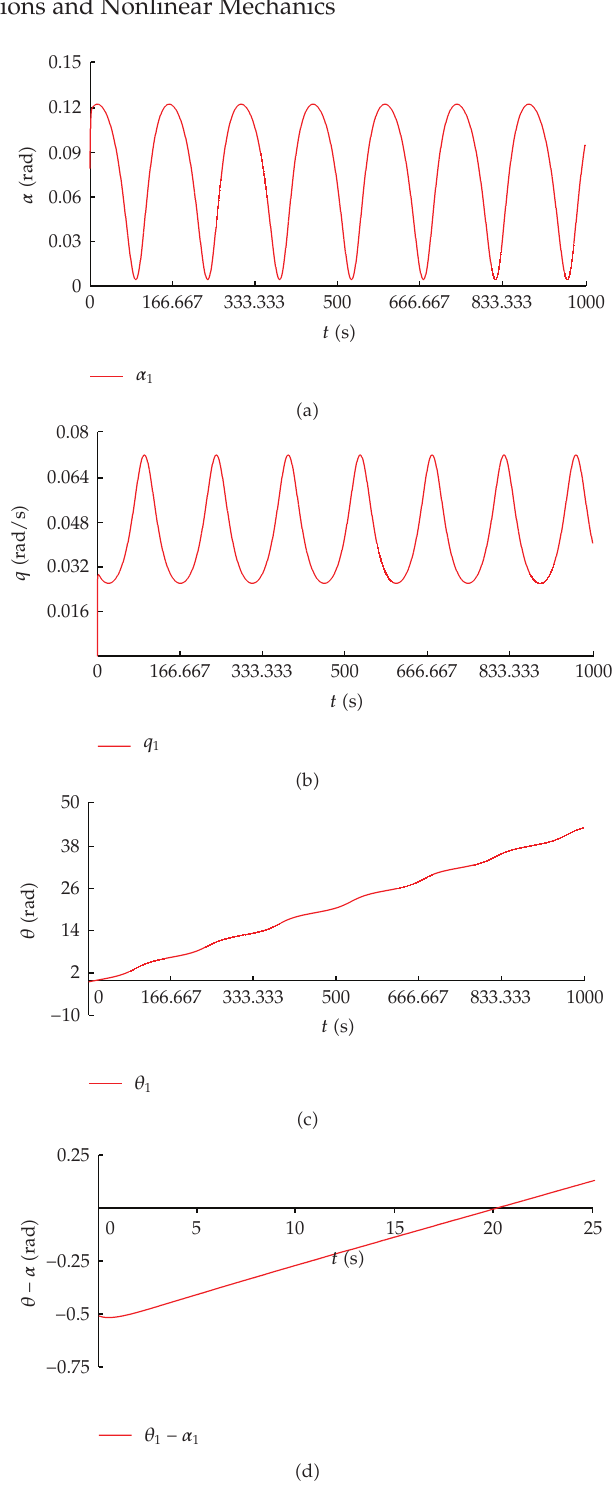
(cid:7) 0 . 0786697 (cid:5) rad (cid:6) (cid:7) 4 . 509 ◦ ; q (cid:6) 1